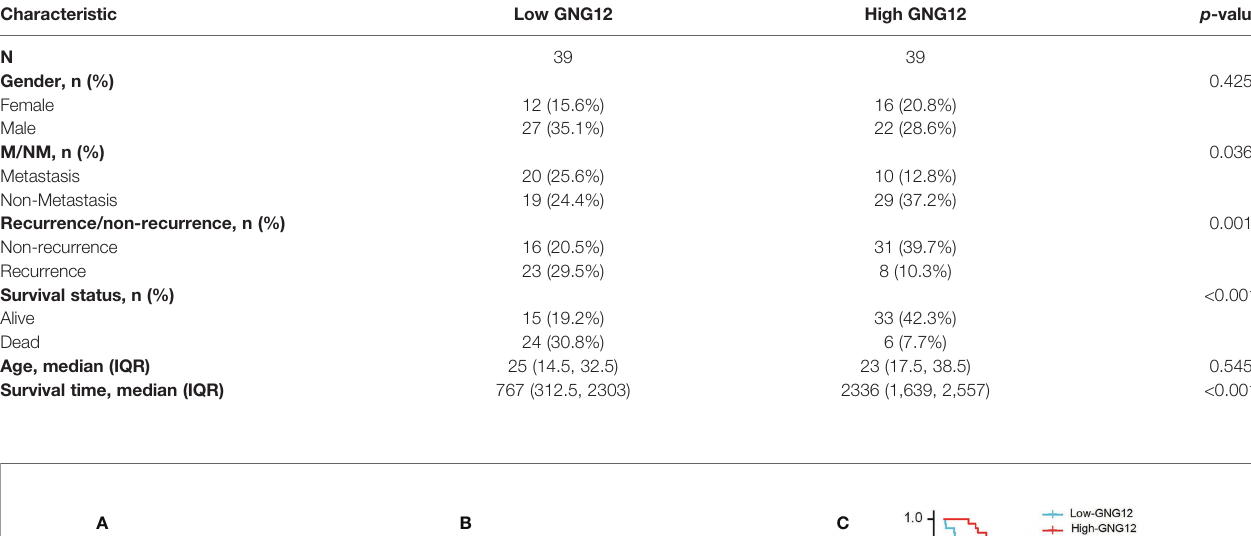
TABLE 1 | Baseline clinical characteristics of validation cohort. Characteristic